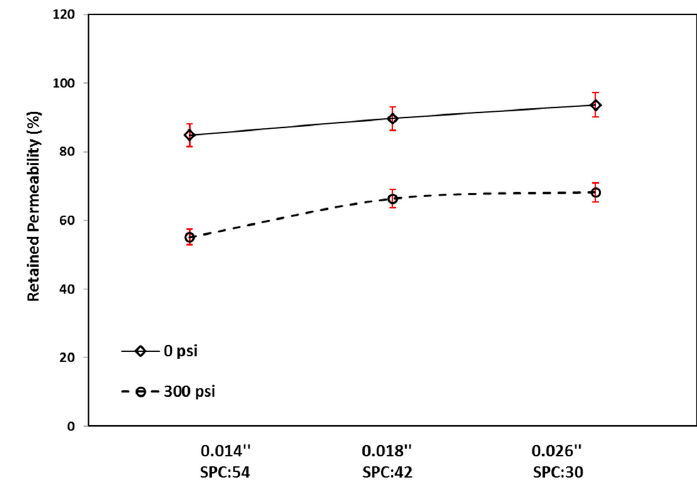
Figure 14. E ff ect of slot size and density on retained permeability at the near-coupon Figure 14. Effect of slot size and density on retained permeability at the near-coupon zone.